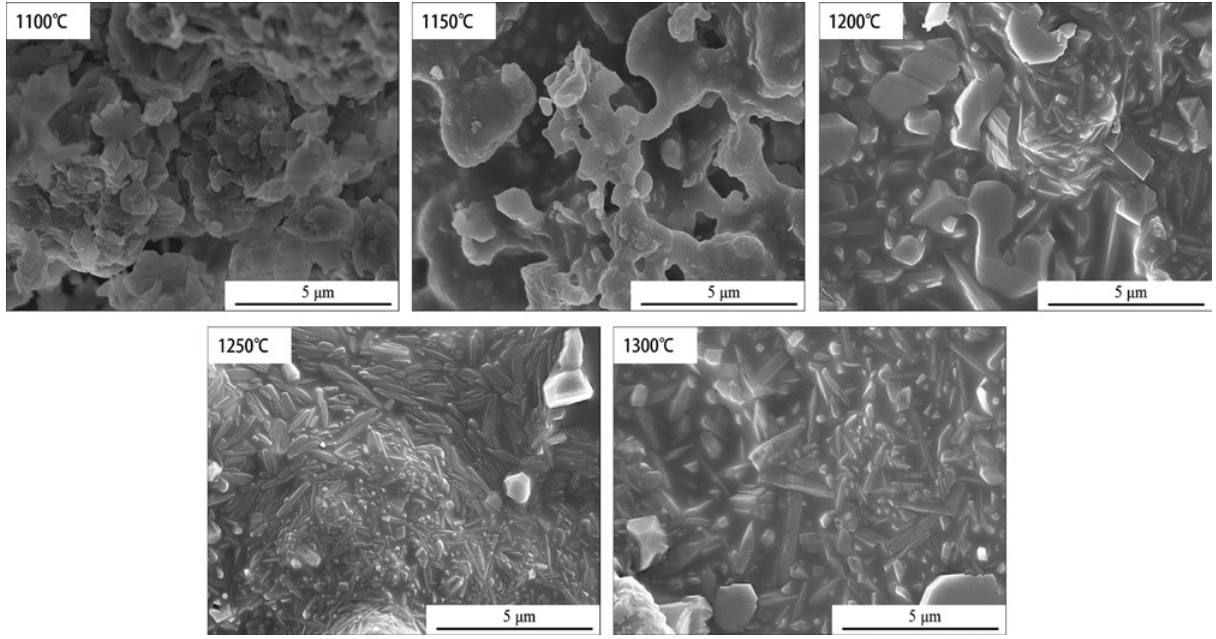
Figure 6: The SEM images of the proppants at different sintering